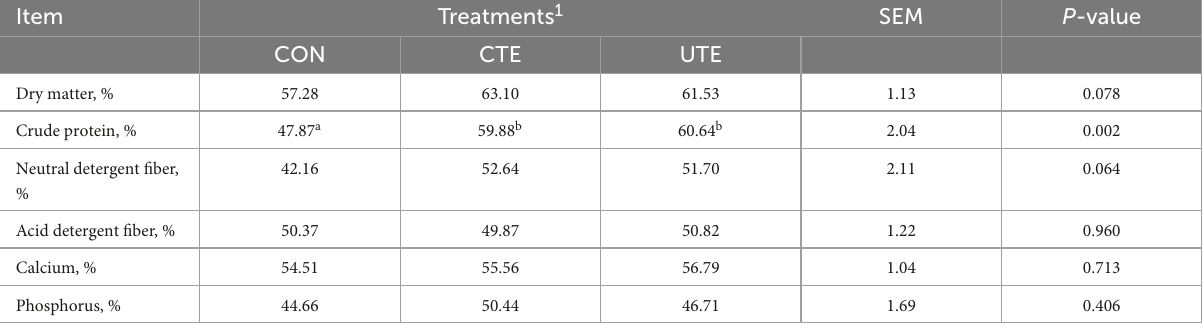
TABLE 4 Effects of coated and uncoated trace elements on total tract apparent digestibility of